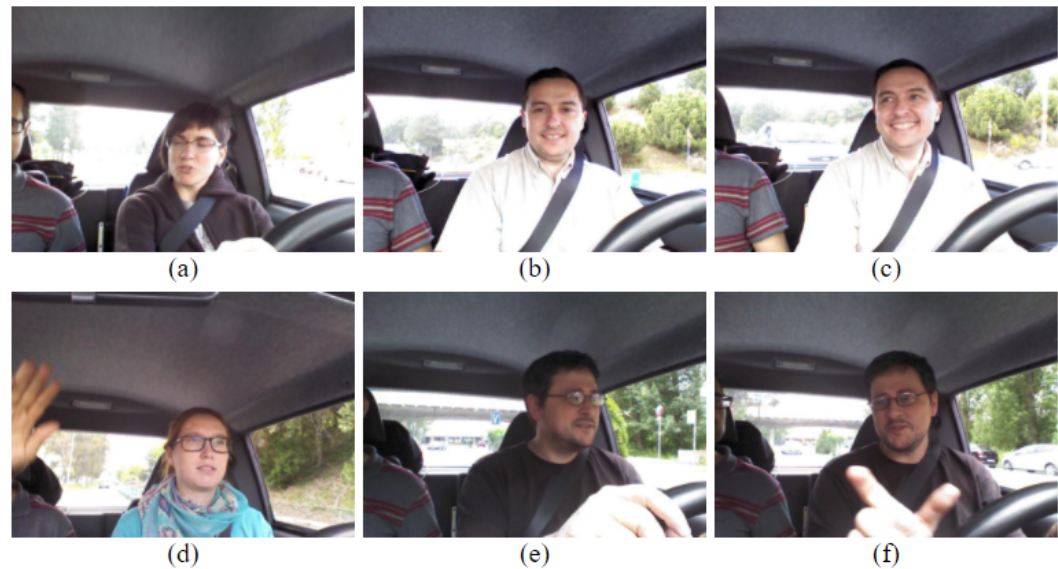
Figure 6. Various frames of the DrivFace dataset depicting various distractions, namely: ( a ) looking right, ( b ) looking forward, ( c ) talking and laughing, ( d ) looking forward and waving a hand, ( e ) head panning left, and ( f ) head panning right and